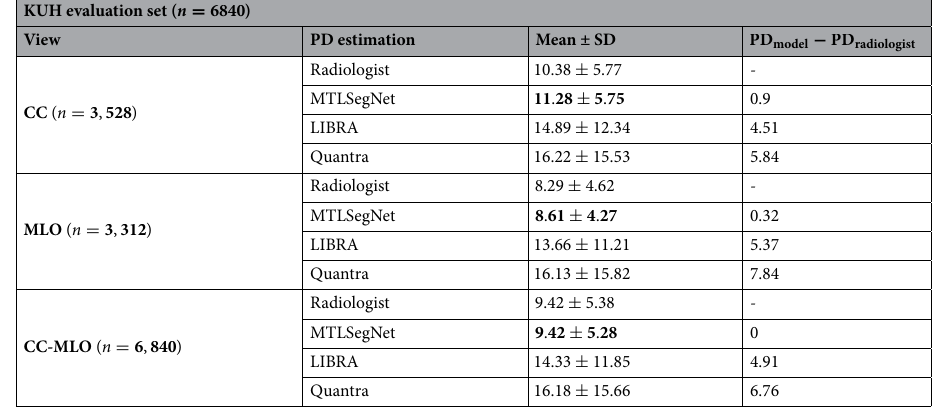
Table 7. Descriptive summary of estimated PD values of MTLSegNet, LIBRA, and Quantra and the radiologist-assessed PD values using the KUH evaluation set. We show the mean and standard deviation (SD) of the PD values for all models. We highlighted the model, whose mean difference is close to the reference (radiologist) mean PD value. Lower the mean difference, better the model performance. Best values are in [bold].